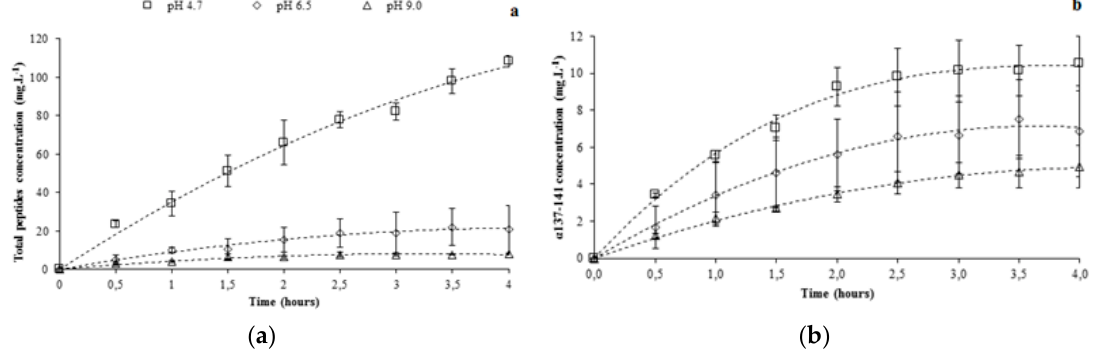
Figure 5. Recovery of total peptides ( a ) and α 137-141 ( b ) during the EDUF treatment using pH control (4.7, 6.5, and 9).